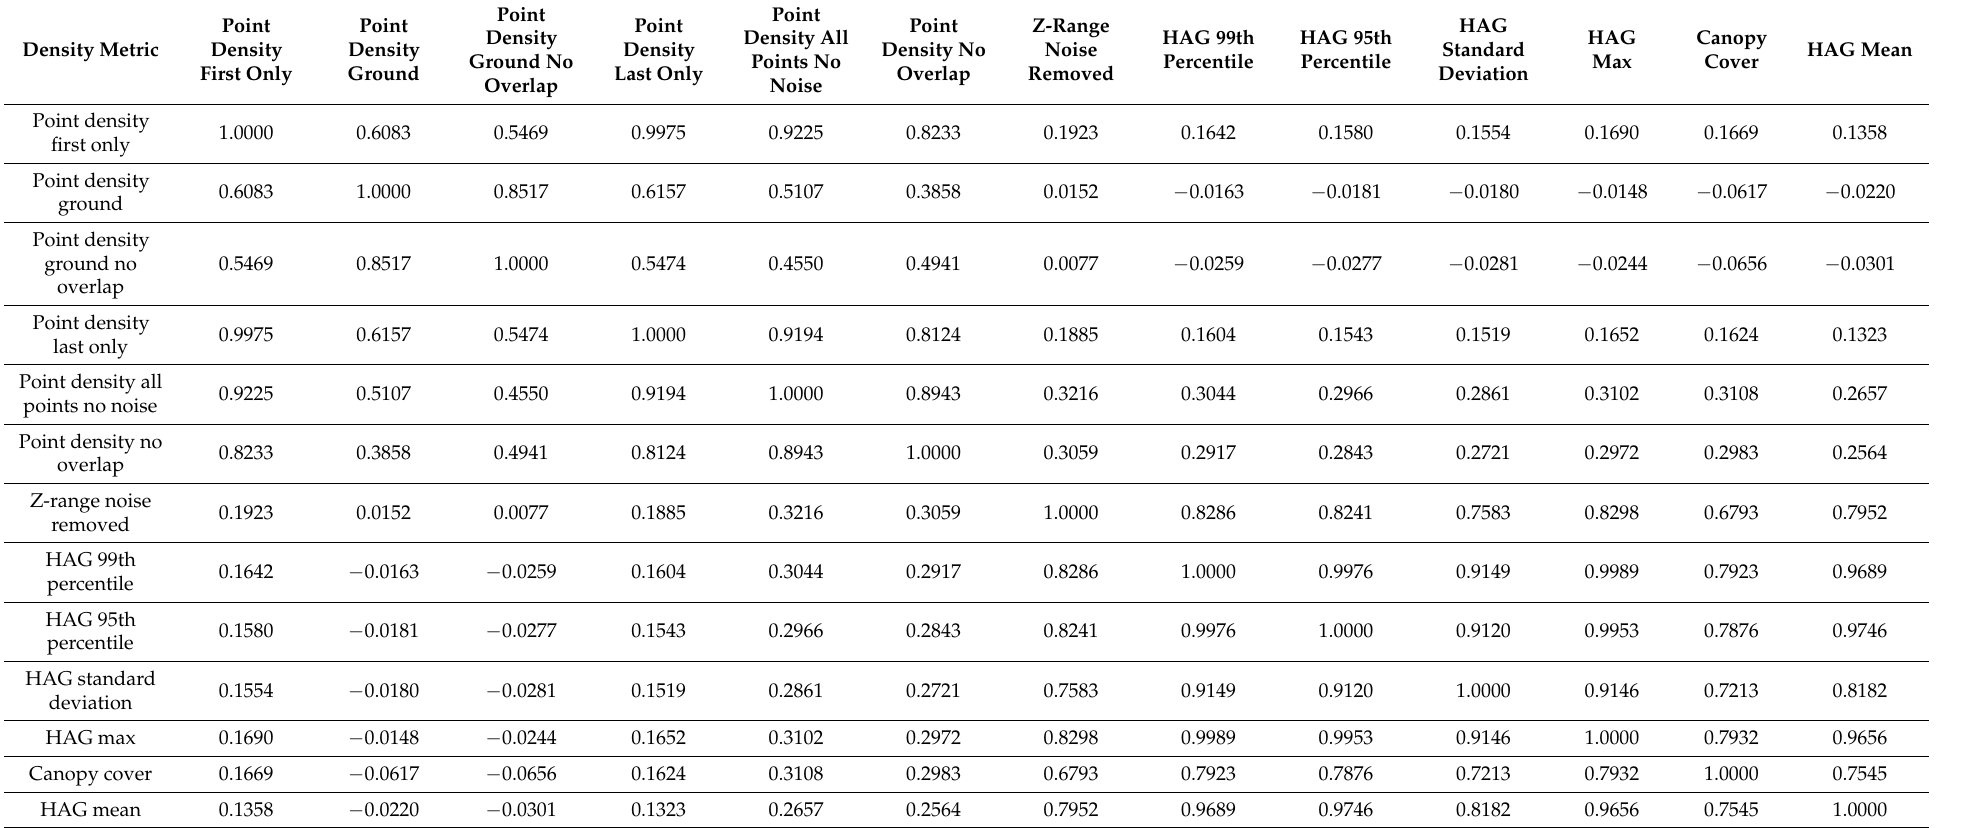
Table 12. Multivariate correlations of density metrics for stratified random sample